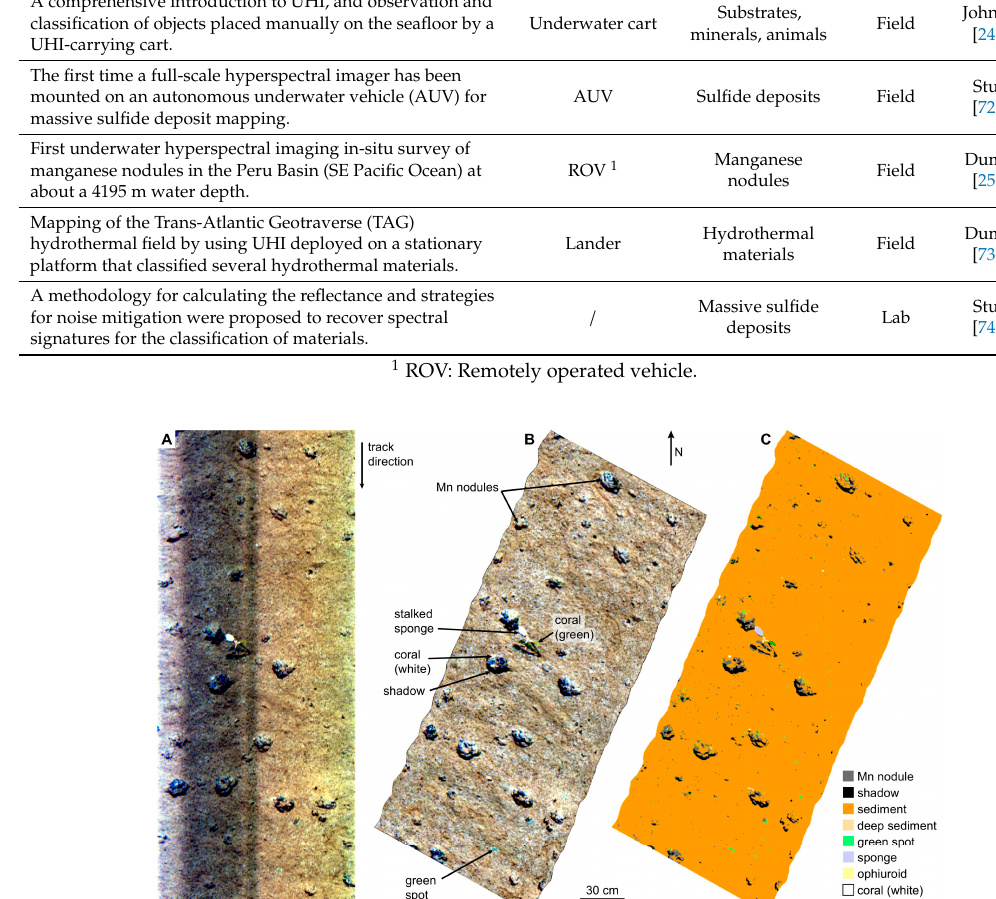
Table 2. Examples of marine mineral exploration conducted by using UHI.